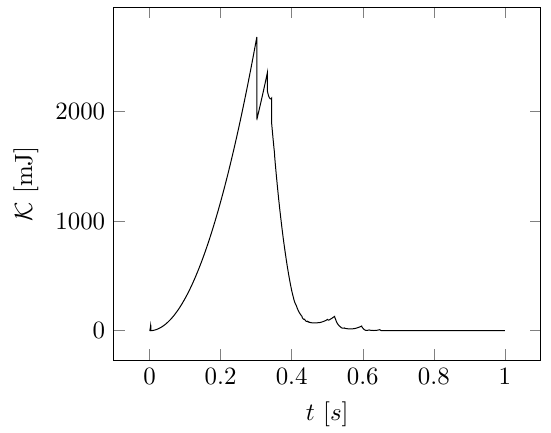
Figure 12. ( a ) The curves representing the angular rotation of each of the three leg structure revolute joint; ( b ) the curves representing the torque response of each of the three VRD’s; ( c ) the curves representing the contact force between each of the legs with the soil.